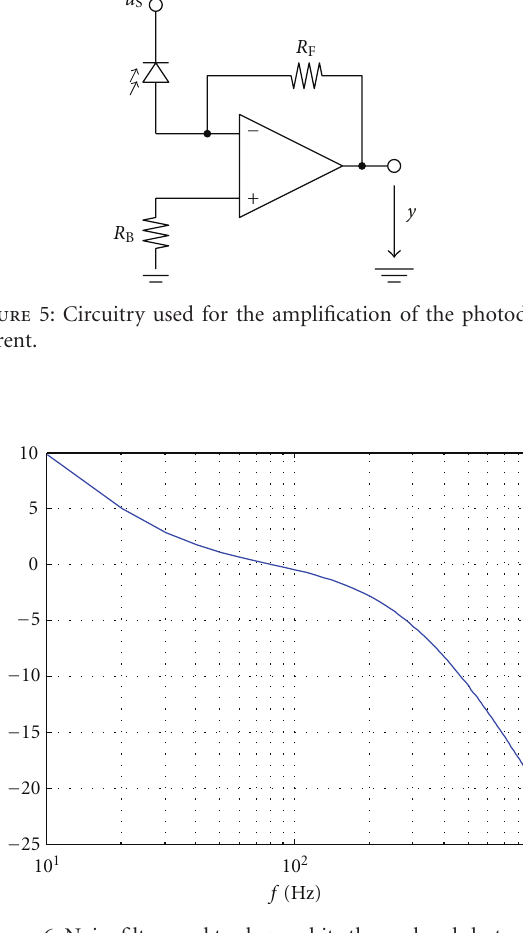
Figure 6: Noise filter used to shape white thermal and shot